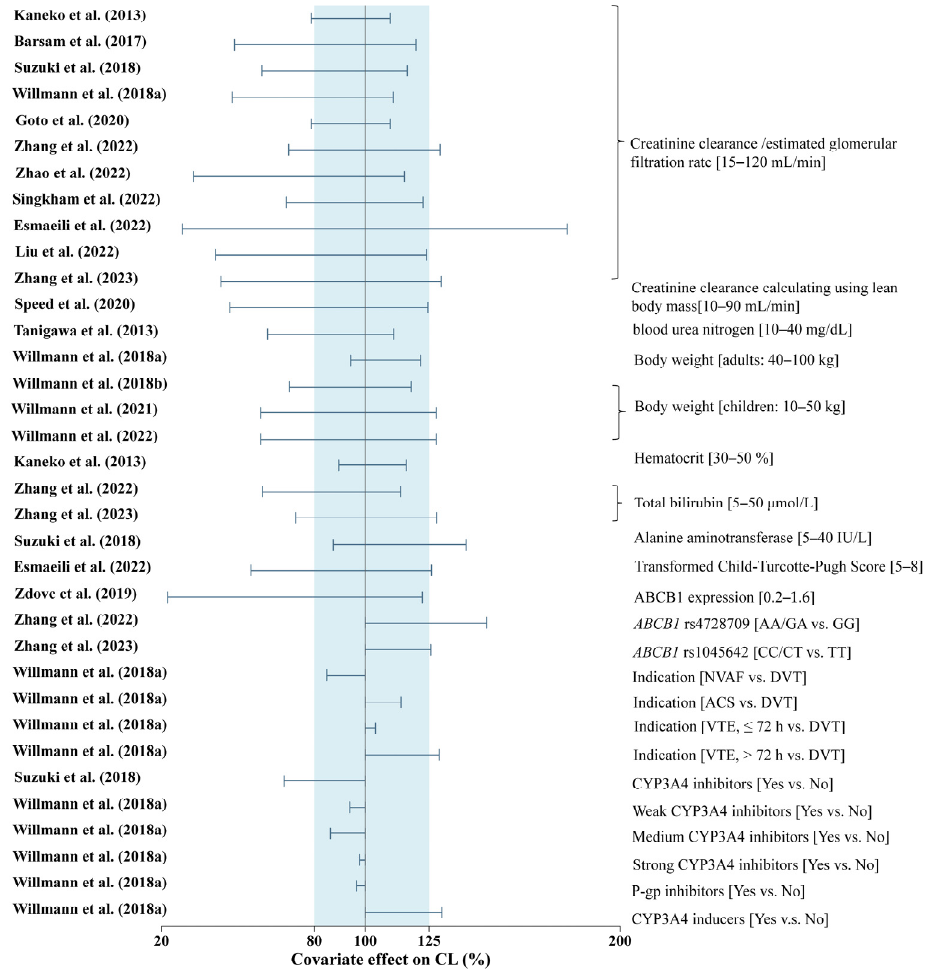
Figure 2. Effect of covariates on the apparent clearance of rivaroxaban. The horizontal bars represent the effect of each covariate on clearance (CL) in each study. The effect of each covariate on CL was characterized as the ratio of CL in the range of each covariate to the typical CL. The gray shadow represents the range of 80–125% [18,20,25,26,28,30,31,33–41].